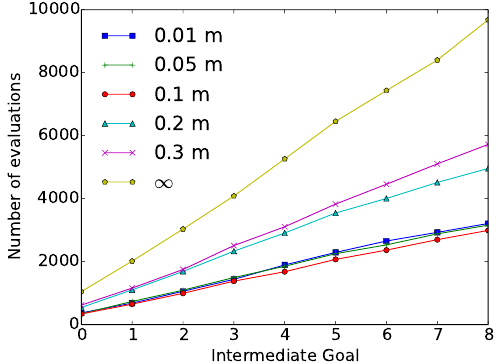
Figure 7. “Wax” geometrical constraint experiment results: Number of cumulative evaluations required at each intermediate goal, as a function of the dilatation value (0.01 m, 0.05 m, 0.1 m, 0.2 m, 0.3 m and ∞ ).